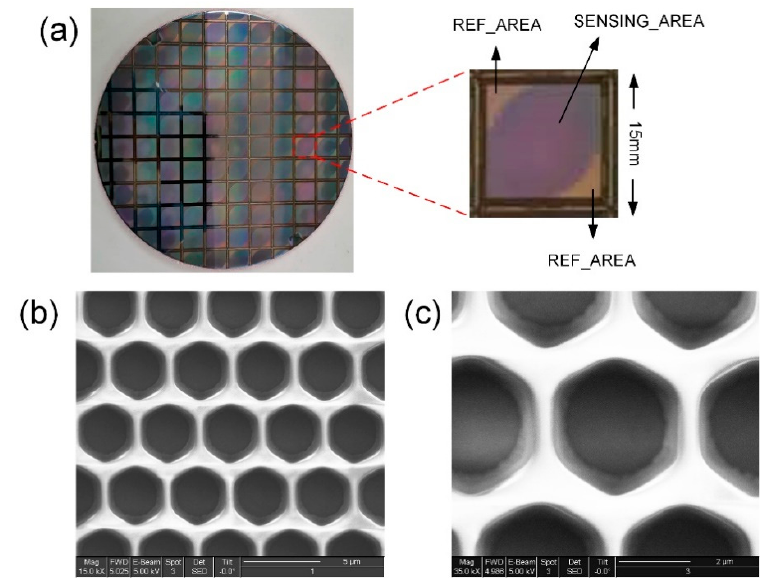
Figure 6. ( a ) The dark bule area in the chip is SENSING_AREA, and the other area is REF_AREA. ( b , c ) Scanning electron micrograph of the ISFET microarray.